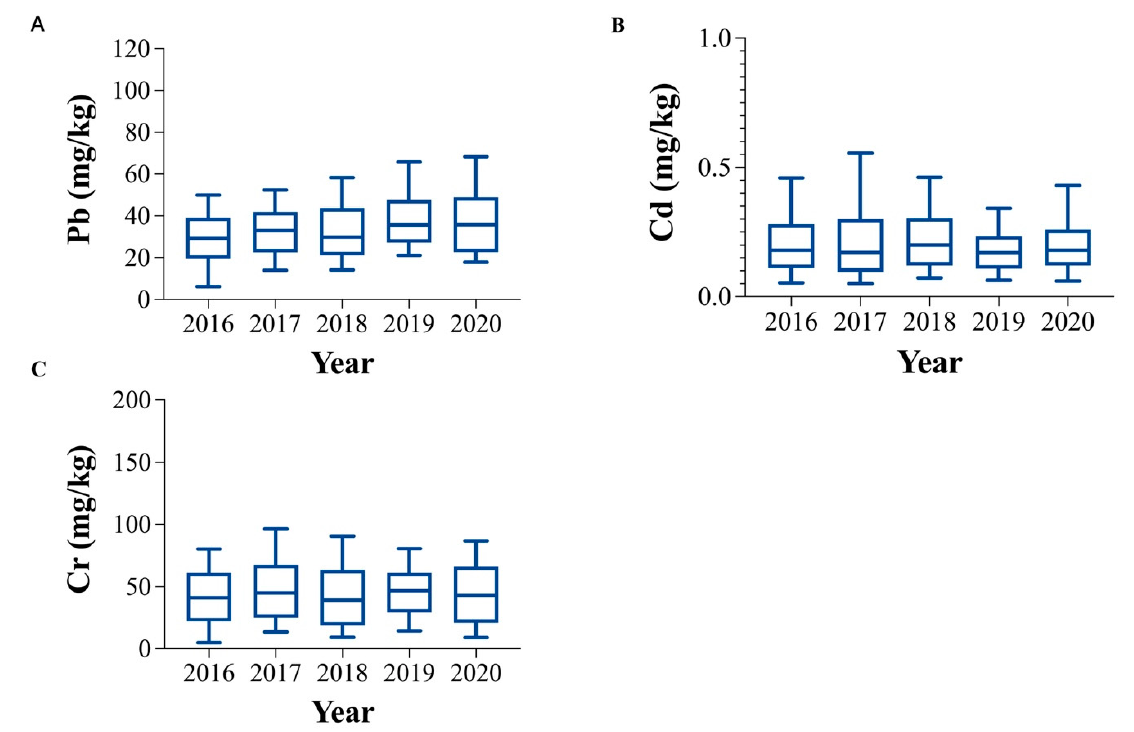
Figure 3. Temporal variations (2016–2020) in heavy metal concentrations (mg/kg) in agricultural soils in Zhejiang. ( A ): Temporal variations in Pb concentrations in agricultural soils in Zhejiang. ( B ): Temporal variations in Cd concentrations in agricultural soils in Zhejiang. ( C ): Temporal variations in Cr concentrations in agricultural soils in Zhejiang.